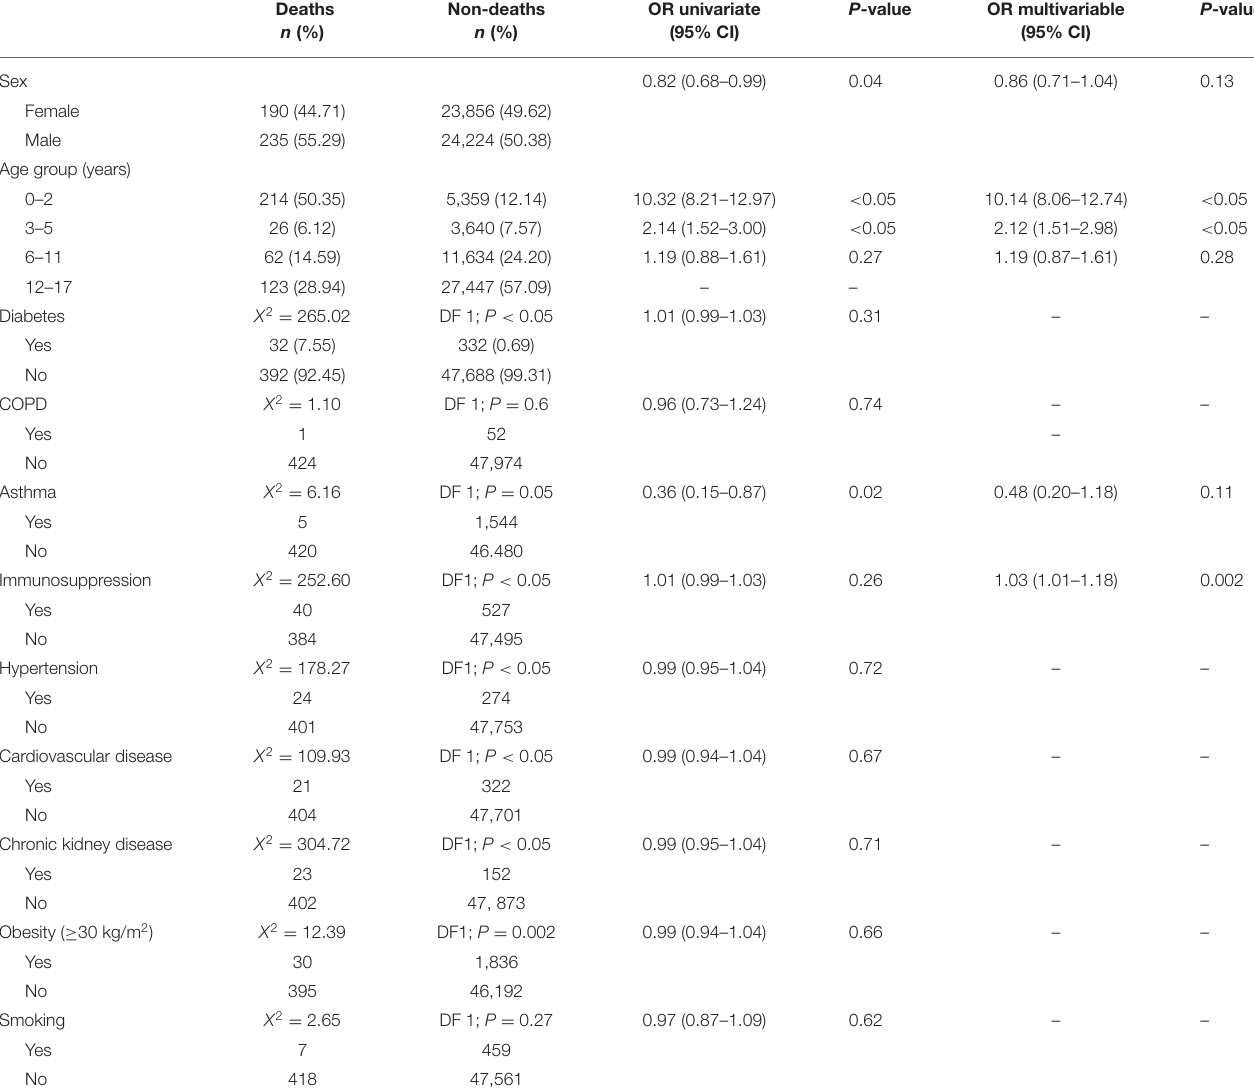
TABLE 2 | Relation between comorbidities and death among COVID-19 confirmed